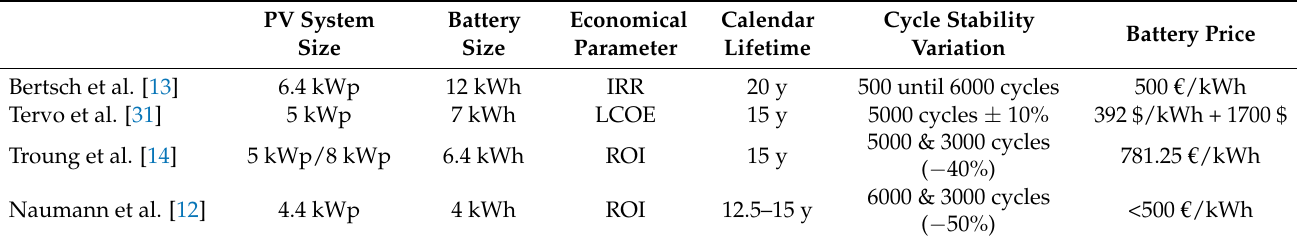
Table 7. Parameters used in the literature to evaluate the influence of cycle stability on economic